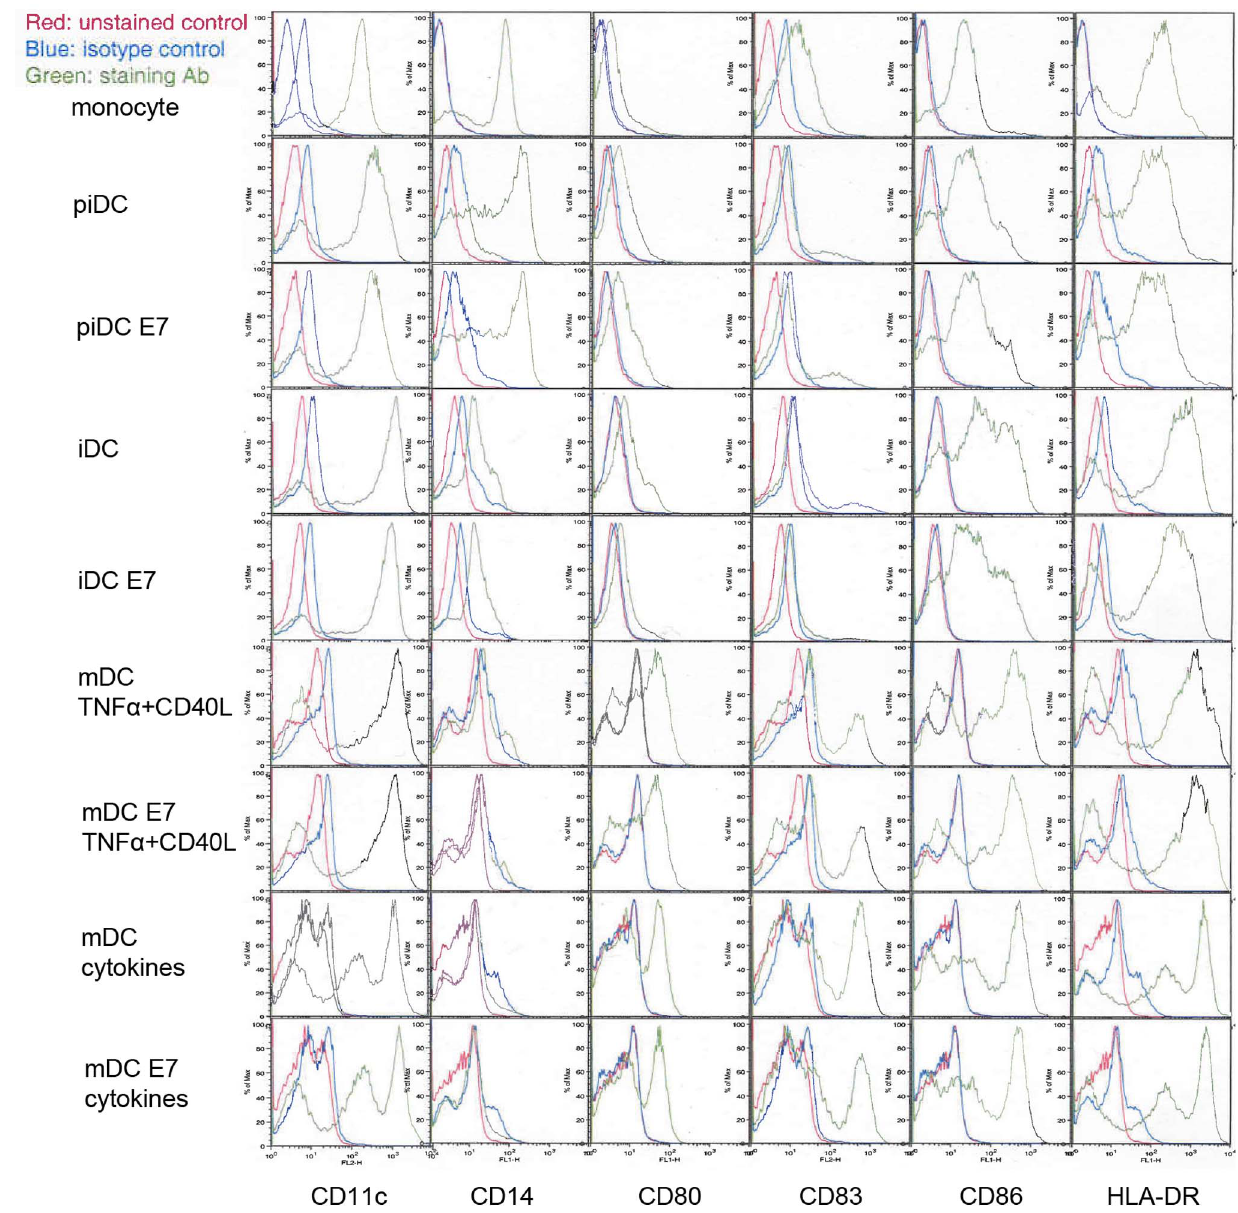
Figure 1. Phenotypes of HPV16 E7 class I peptide pulsed piDC, iDC and mDC. Expression of surface molecules CD11c, CD14, CD83, CD86 and HLA-DR were detected by incubating of monocytes and DCs with FITC-labeled antibodies and analyzed with flow